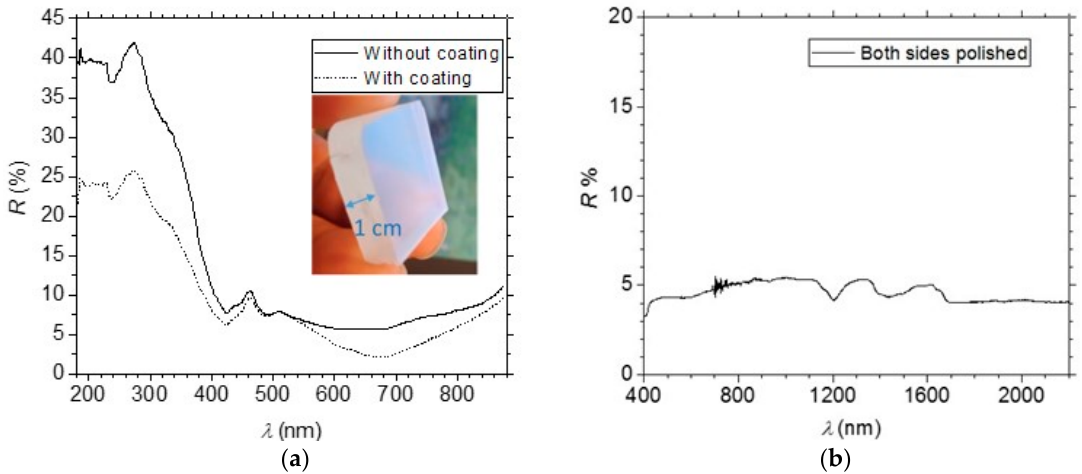
Figure 7. ( a ) Measured reflection of SC sample with and without anti-reflection coating of TiO 2 /MgF 2 . Inset image shows the sample with the coating—the thin film looks opaque away from orthogonal incidence. Significant suppression of Fresnel reflections are observed, including below the band-edge in the UV. The maximum observed drop is~ λ = 680 nm at the red/near IR edge. Inset shows the coated sample; ( b ) Measured VIS-NIR reflection after both sides of the VC sample were polished, demonstrating significant scattered light as function of wavelength without a coating in the SC sample. The VC reflection is close to wavelength-independent except where some absorption (C–F) within the sample occurs.